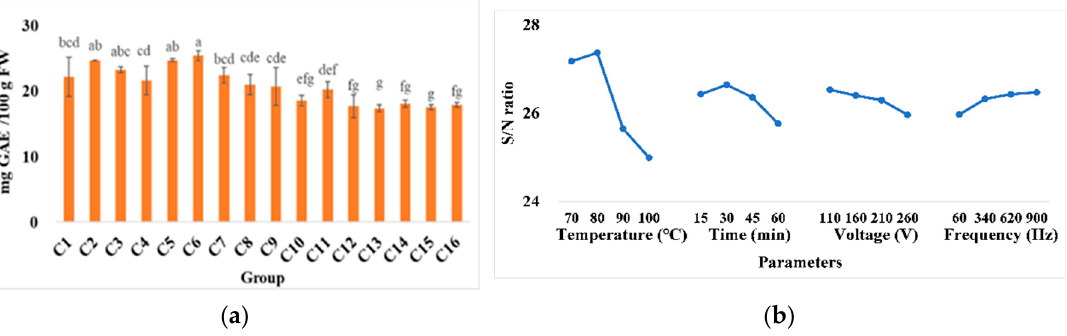
Figure 5. ( a ) The total phenolic content, and ( b ) response graph of higher-better signal-to-noise ratio of various conditions in ohmic heating. Values C1–C16 represent pineapple cores in different treat-ment conditions including temperature (°C), time (min), voltage (V), and frequency (Hz), respec-